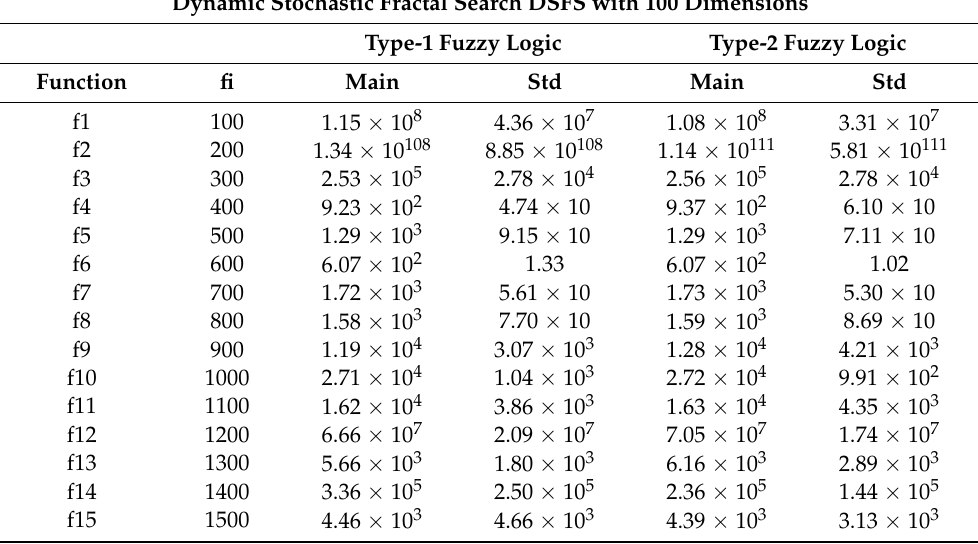
Table 5. Dynamic Stochastic Fractal Search (DSFS) results with 100